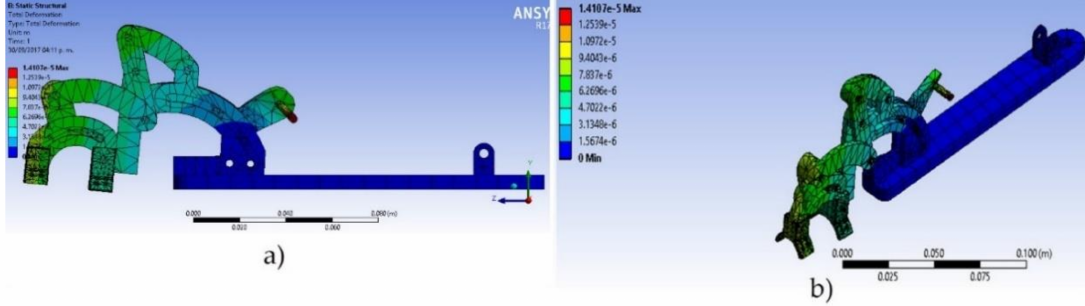
Figure 10. Results obtained in the “total deformation” simulation, where ( a ) shows the side mechanism view and ( b ) shows the same isometric